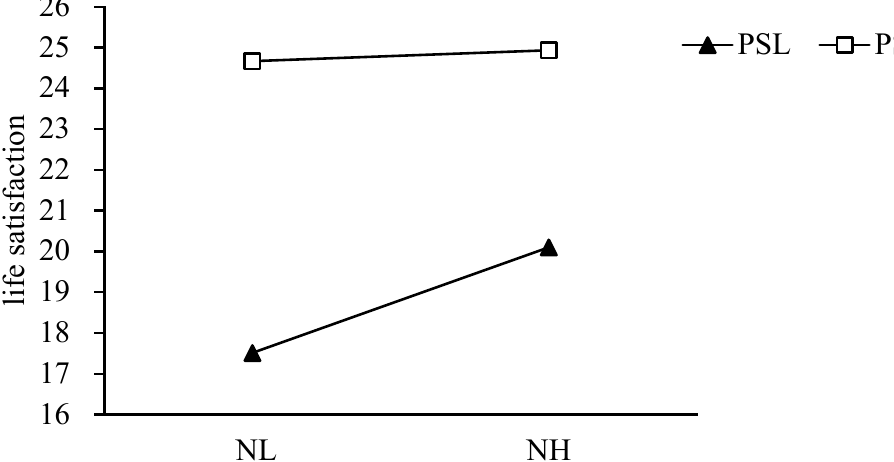
Figure 1. The moderating effect of perfectionistic strivings on the relationship between basic psy ‐